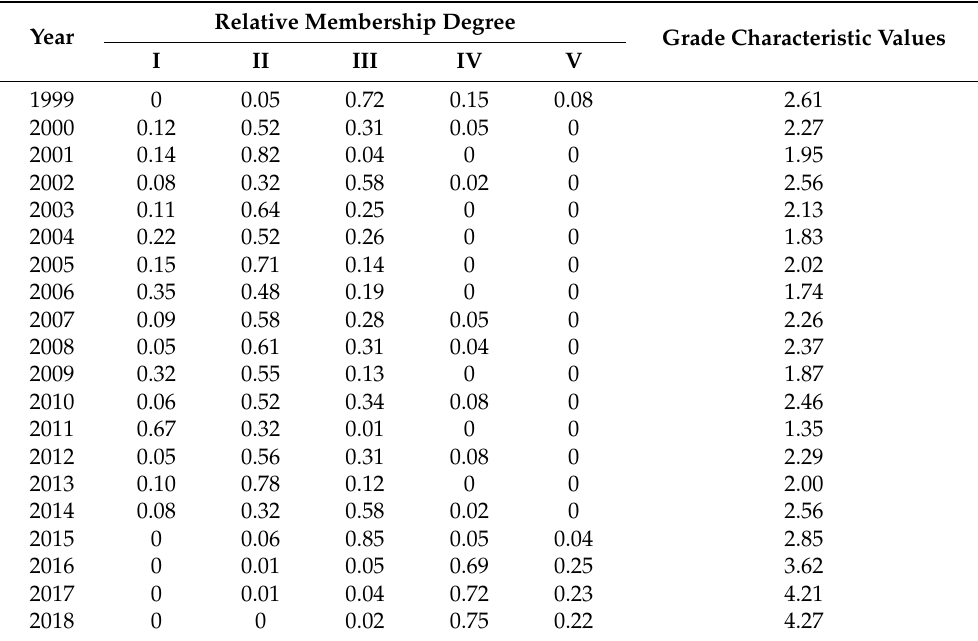
Table 4. The relative membership degree and grade characteristic values of the Yangtze River Economic Belt from 1999 to